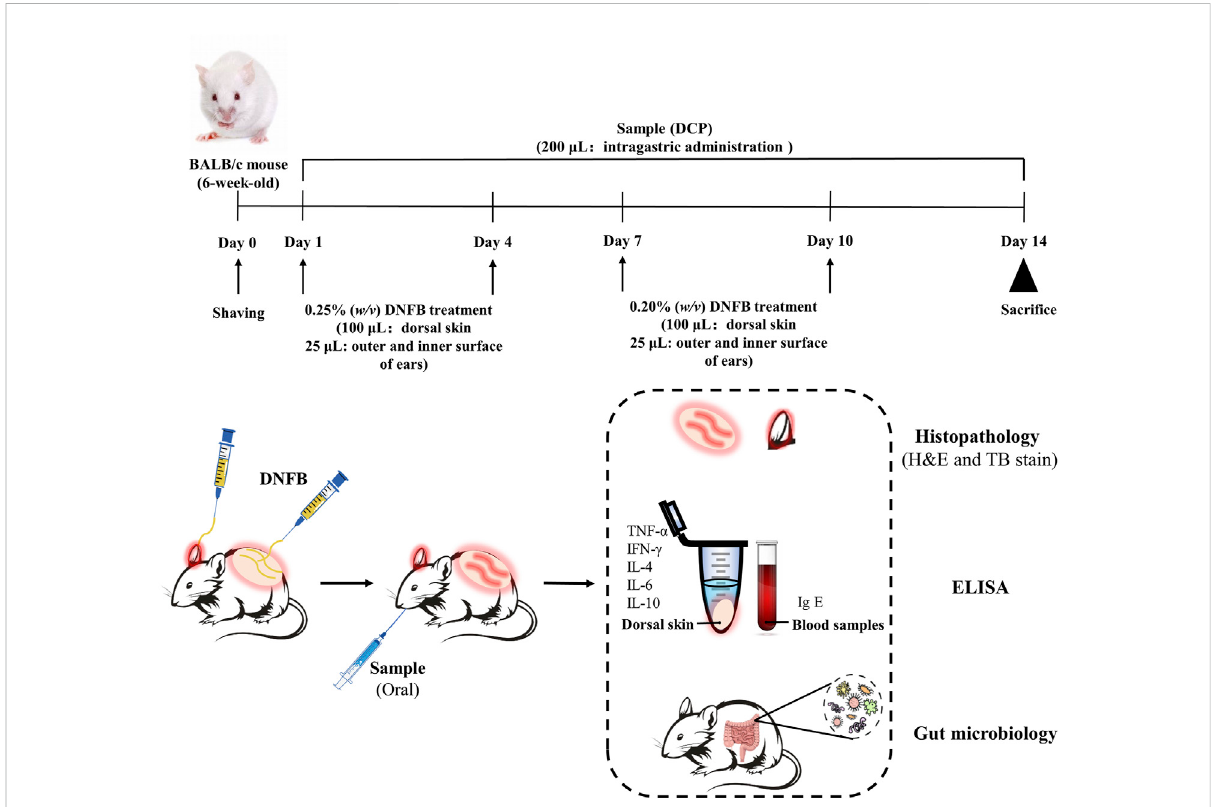
FIGURE 1 ExperimentalprotocolforDNFB-inducedAD-likelesionsandoraltreatmentofDCPinBALB/cmice.24femaleBALB/cmice(6-week-old)were randomly divided into four groups ( n = 6 per group): Blank control group, DNFB-induced AD-like model group, treatment group with DCP at 50 mg/kg and treatment group with DCP at 200